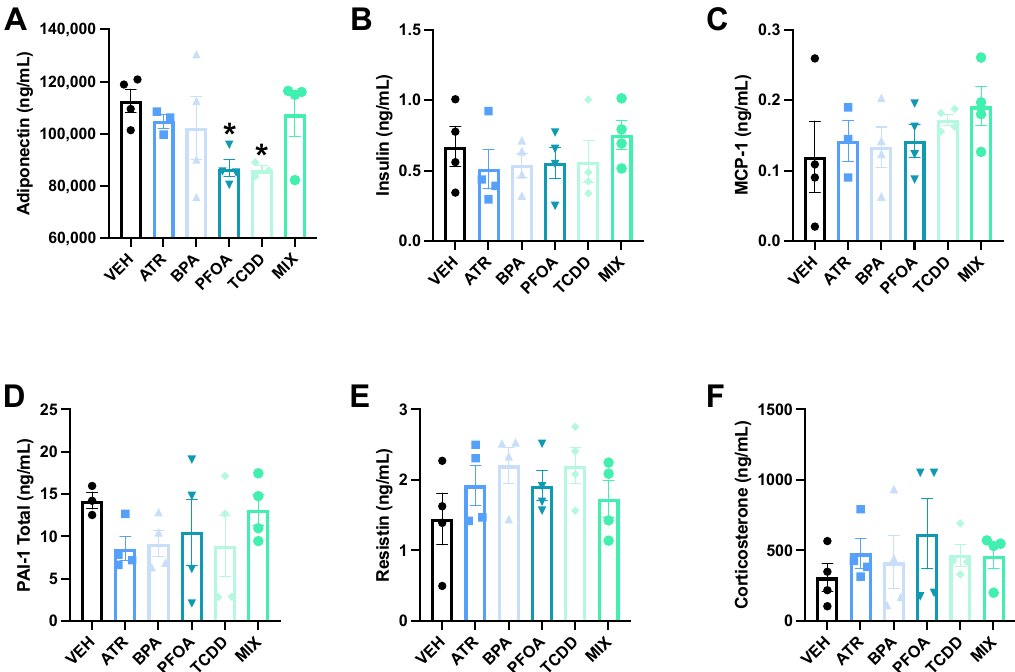
Figure 4. Pregnant Dams Serum Adipokines and Corticosterone. Various adipokines were analyzed following the glucose tolerance test: adiponectin ( A ), insulin ( B ), MCP-1 ( C ), PAI-1 total ( D ), and resistin ( E ). Adiponectin was significantly decreased in the single EDCs, PFOA and TCDD ( A ). No difference was observed between the remaining serum adipokines in any other treatment group. No difference was observed in corticosterone following the glucose tolerance test either ( F ). Data are shown as mean ± standard error ( n = 3 – 4/group). Asterisk indicates p ≤ 0.05.